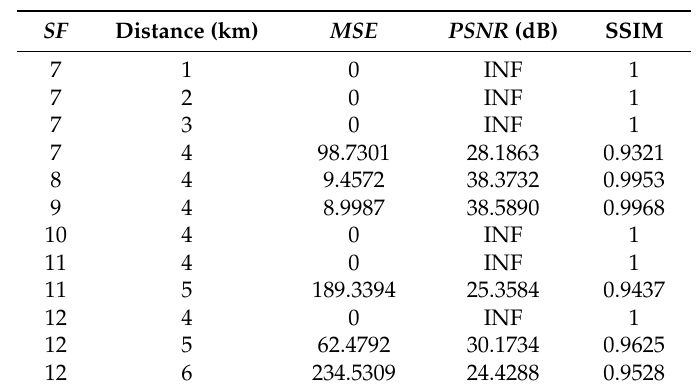
Table 6. Summary of image quality metrics ( MSE , PSNR , and SSIM) calculated using MATLAB.